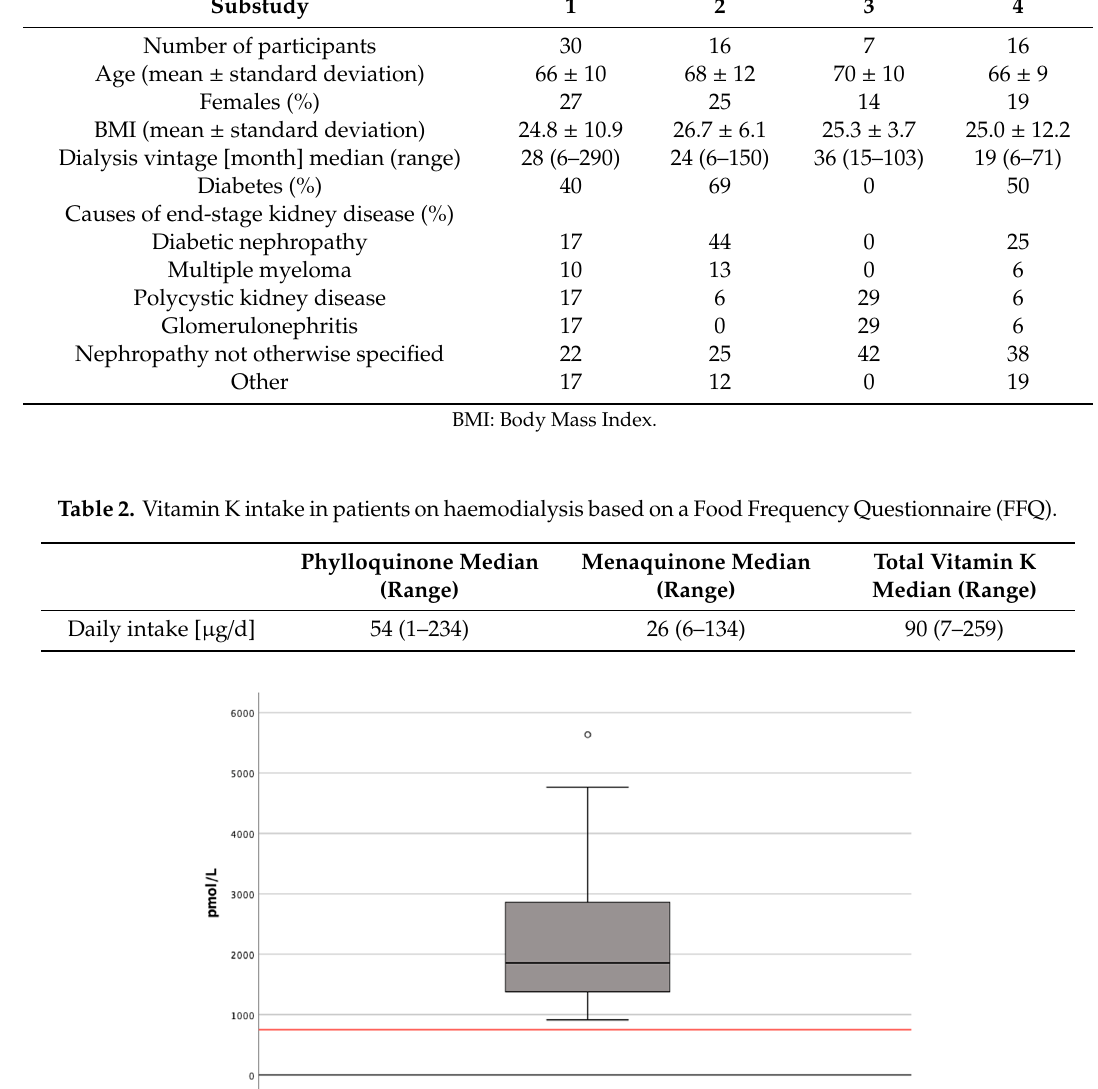
Table 1. Baseline characteristics of the participants in the four substudies on vitamin K deficiency.